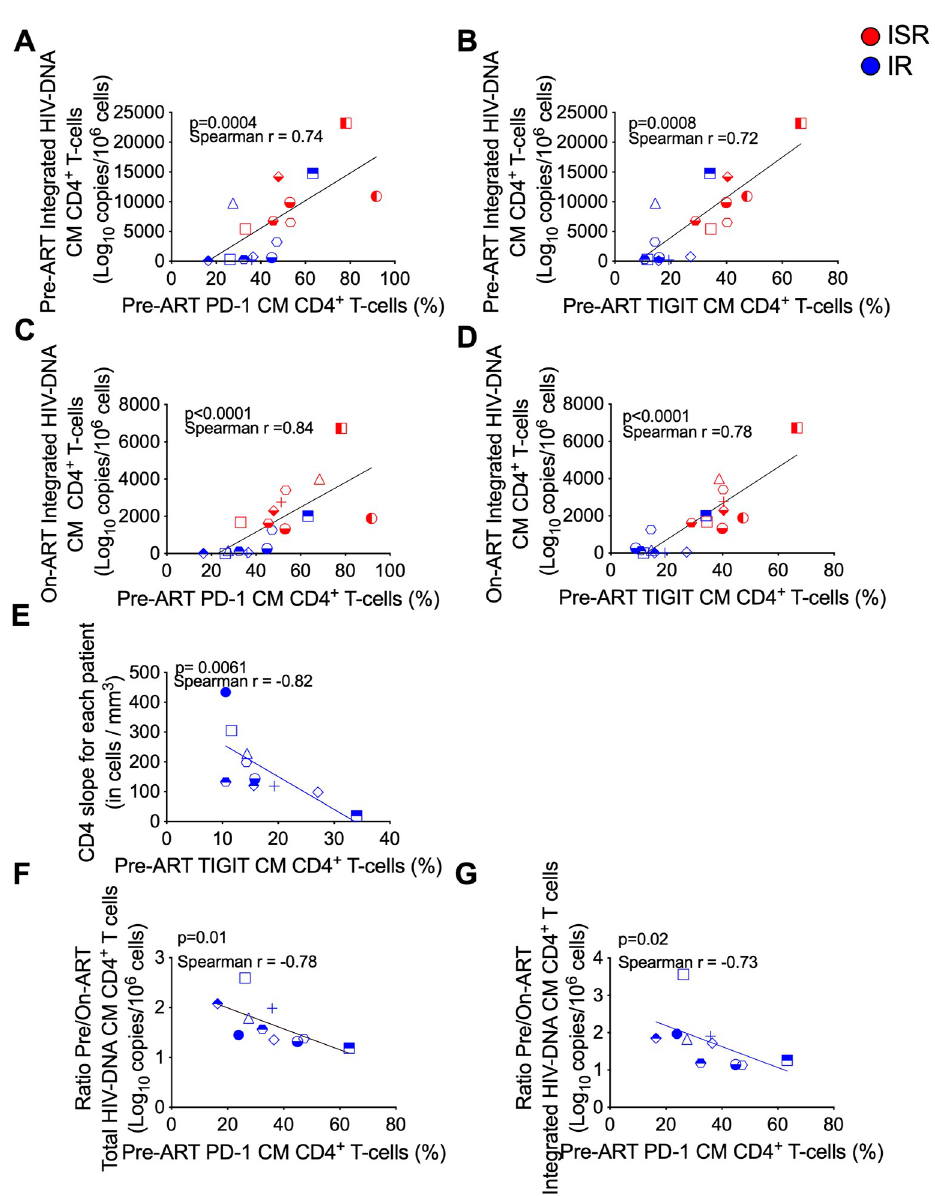
Fig 3. Expression of co-IRs on CD4 CM T-cells correlate with HIV-DNA content pre-ART and during ART. (A-D) Correlation of PD-1 (A, C), and TIGIT (B, D) expression levels on central memory (CM) cells at pre-ART with integrated HIV-DNA on CM cells at pre- (A, B; IR, blue; n = 10, ISR, red; n = 7), and at on-ART (C, D; IR n = 10; ISR n = 9) for all individuals with HIV (n = 18). (E) Correlation of TIGIT expression levels on CM at pre-ART with CD4 T-cell recovery (CD4 slope; cells/mm 3 ) on immunologic responders (IR) (n = 10). (F) Correlation of PD-1 expression on CM cells at pre-ART with ratio pre-ART/On-ART ((Log 10 copies pre-ART/10 6 cells)/(Log 10 copies on-ART/10 6 cells)) of total, and (G) integrated HIV-DNA on CM cells on IR, individuals with HIV (n = 9). Spearman rank correlation test was used to determine correlations.